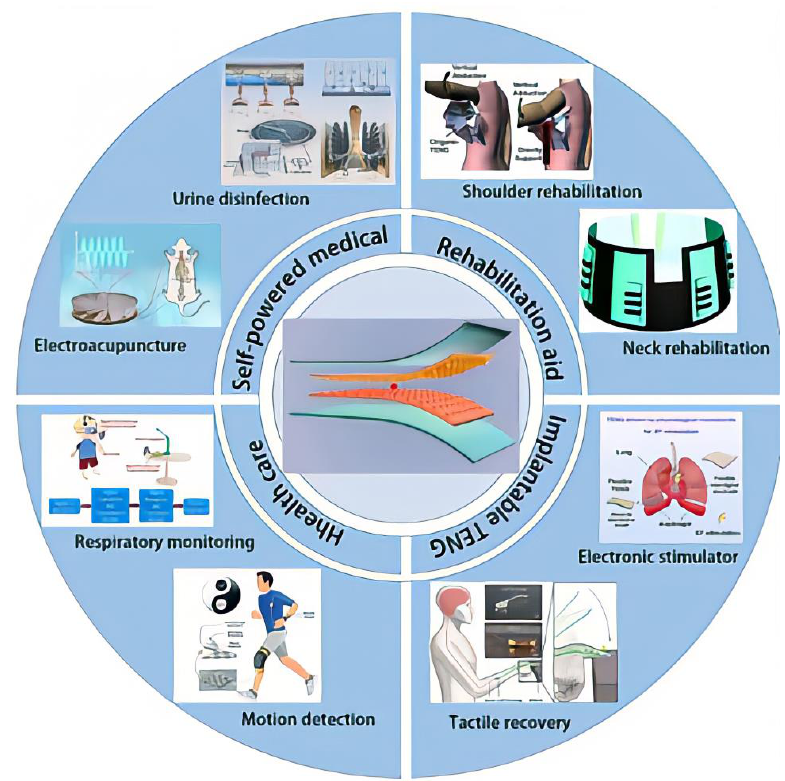
Figure 1. Schematic illustration of TENGs for biosensing, which includes wearable, implantable, and TENG as an external power source for third-party biosensors.